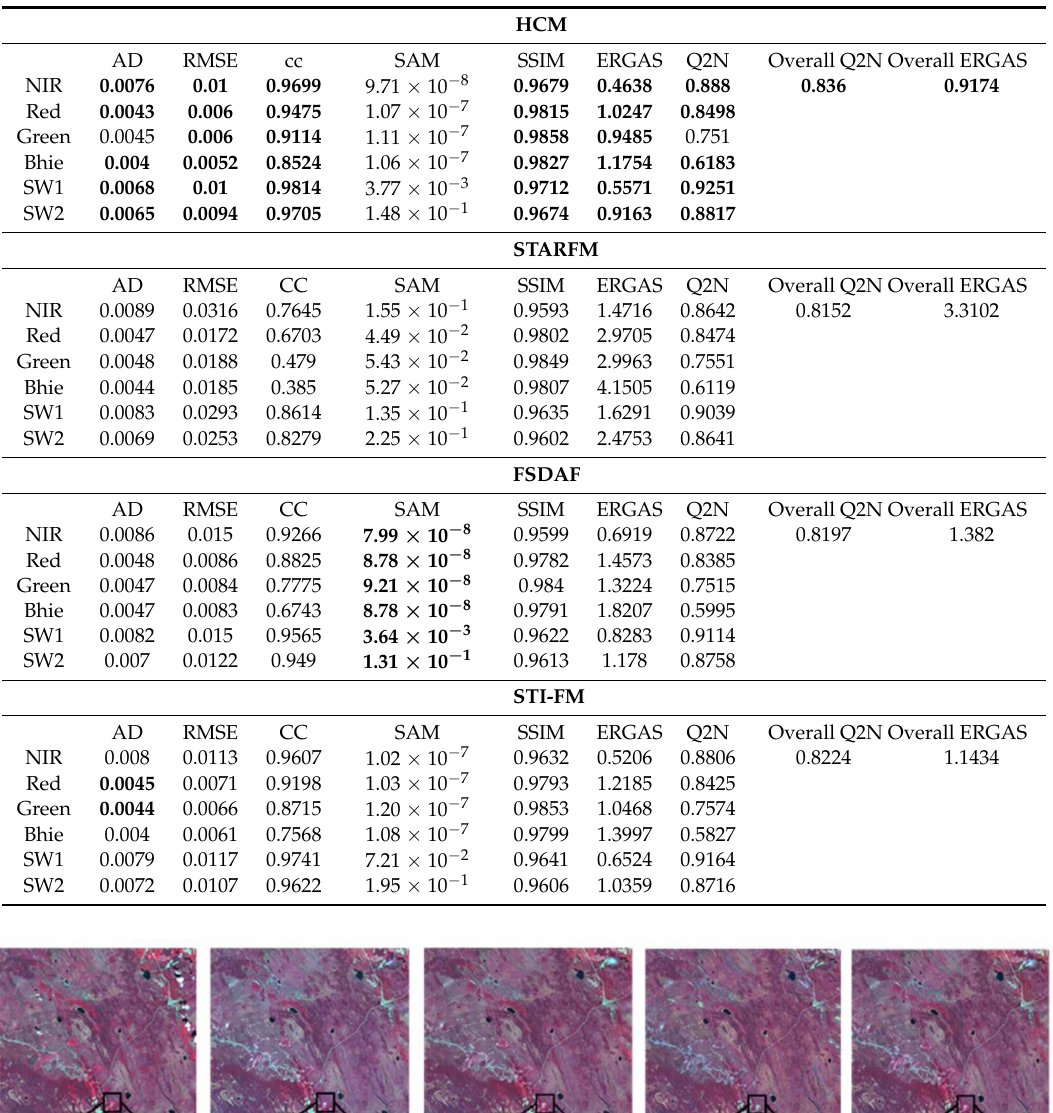
Table 2. Comparison of forward prediction results of using Landsat image 128 to predict Landsat image 144.